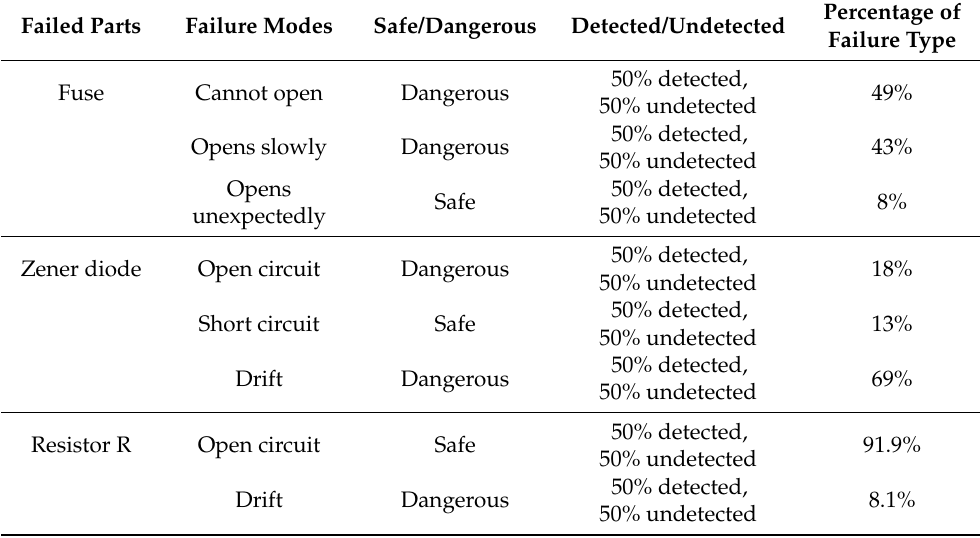
Table 4. Failure mode of intrinsic safety circuit.